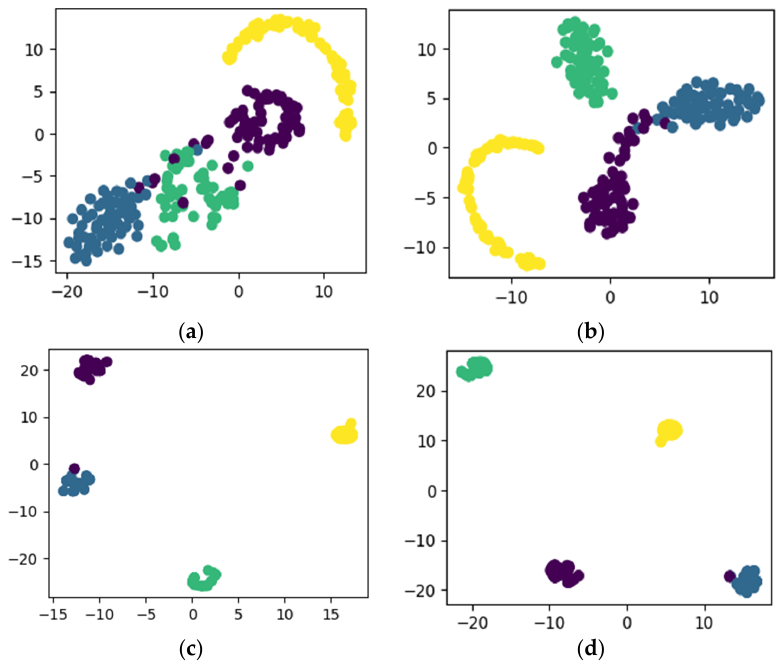
Figure 14. The t-SNE for self-learning ability utilizing dataset configuration C: ( a ) raw data, ( b ) con- volution layer, ( c ) convolution layer, and ( d ) final classification.